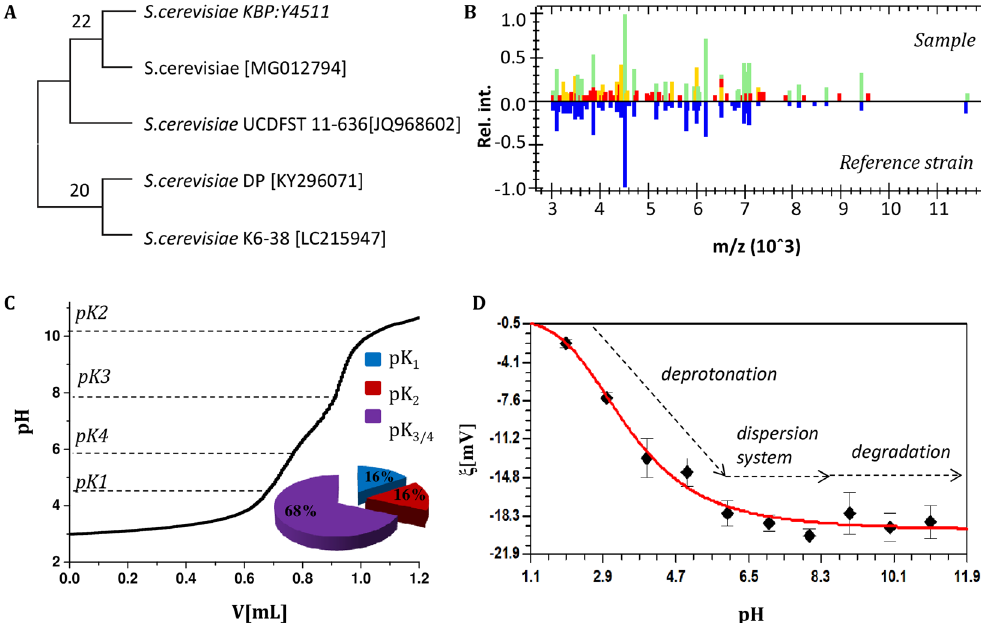
Figure 1. Phylogenetic tree of investigated Saccharomyces cerevisiae strain ( A ). MALDI-TOF MS spectra of native tested yeast and Saccharomyces cerevisiae INVSc1 BRL ( B ). Potentiometric titration curve of S . cerevisiae in anaerobic conditions and number of pK a obtained for surface functional groups of S . cerevisiae ( C ). The zeta potential value of S . cerevisiae biocolloids in function of different pH ( D